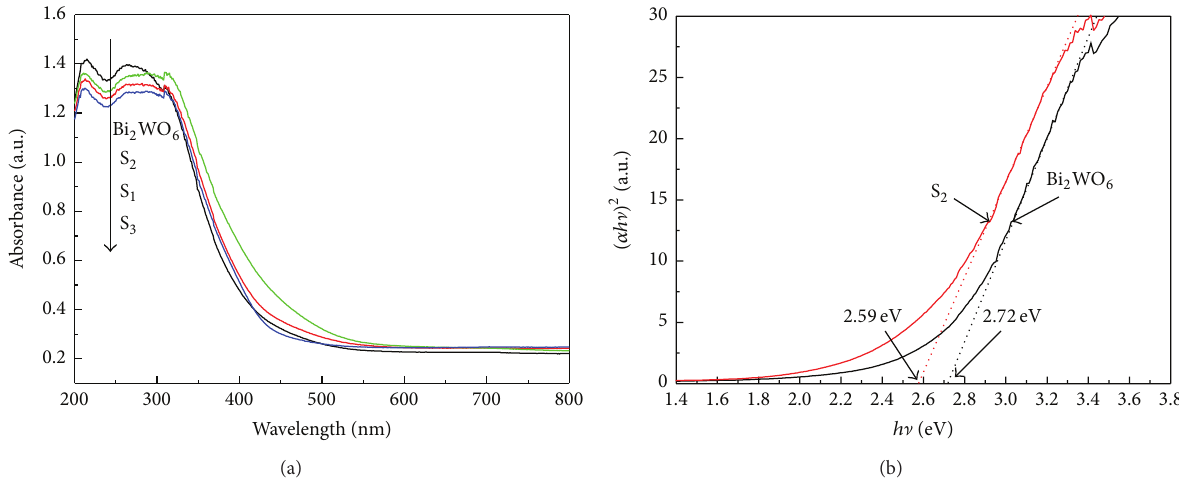
Figure 4: (a) UV-vis absorption spectra of Bi 2 WO 6 , S 1 , S 2, and S 3 and (b) calculation of the band gap by Bi 2 WO 6 and S 2 by Kubelka-Munk function.